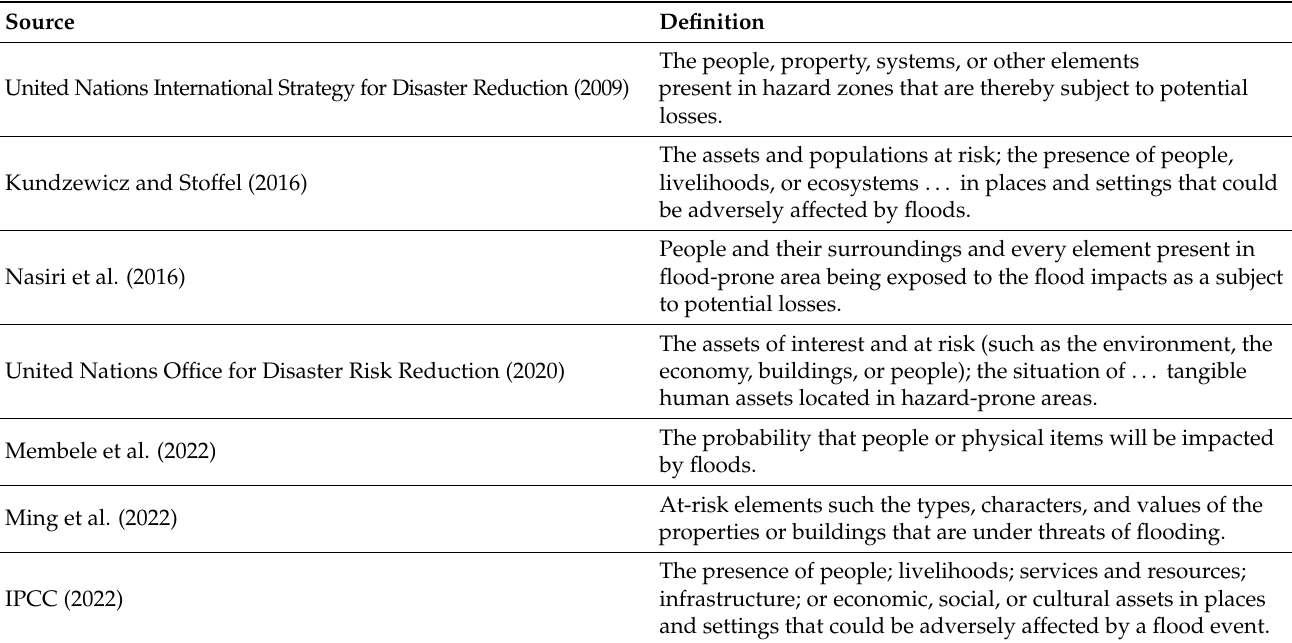
Table A1. Examples of flood exposure definitions present in the literature. Note that flood